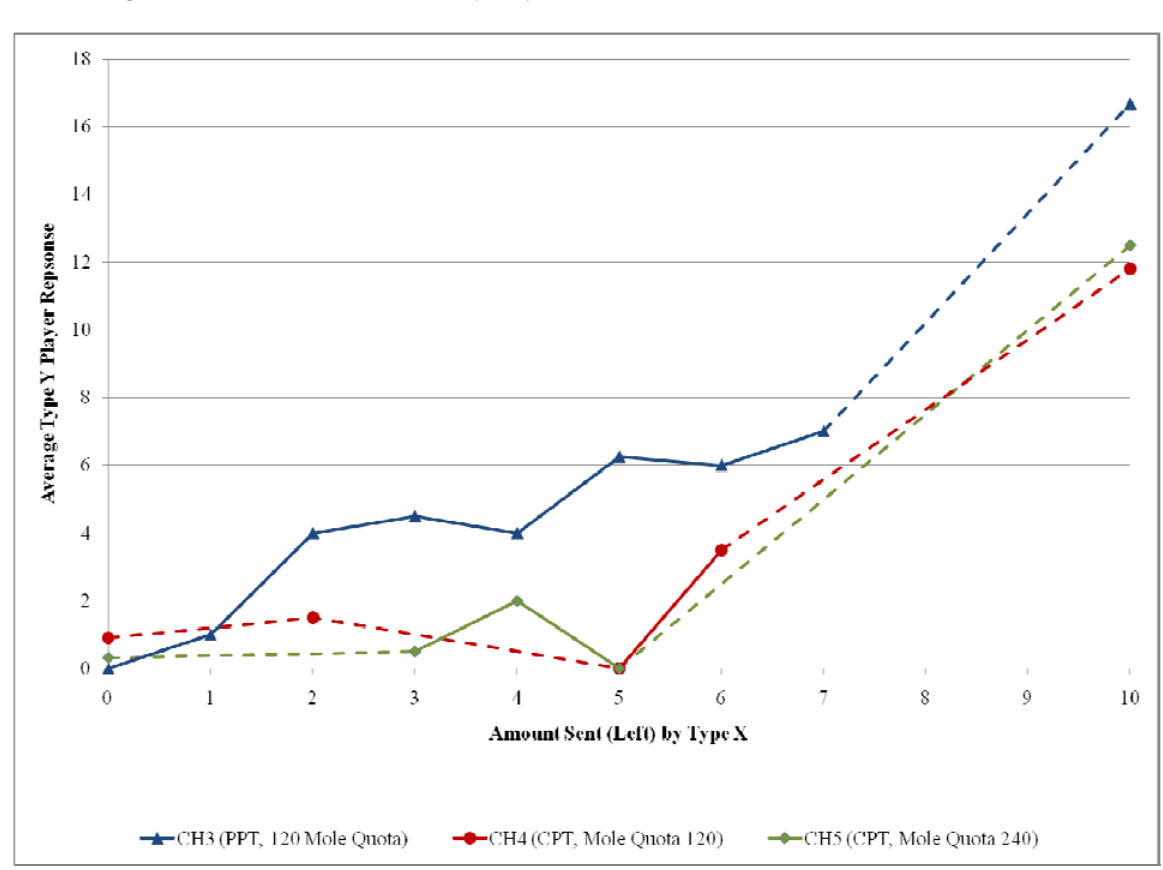
Figure 6. Comparison of average Type Y response data for CH3, CH4, and